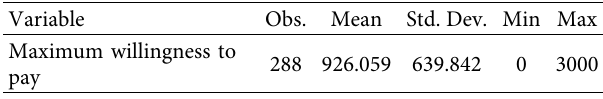
Table 6: Households’ minimum, maximum, and mean willingness to pay for better irrigation